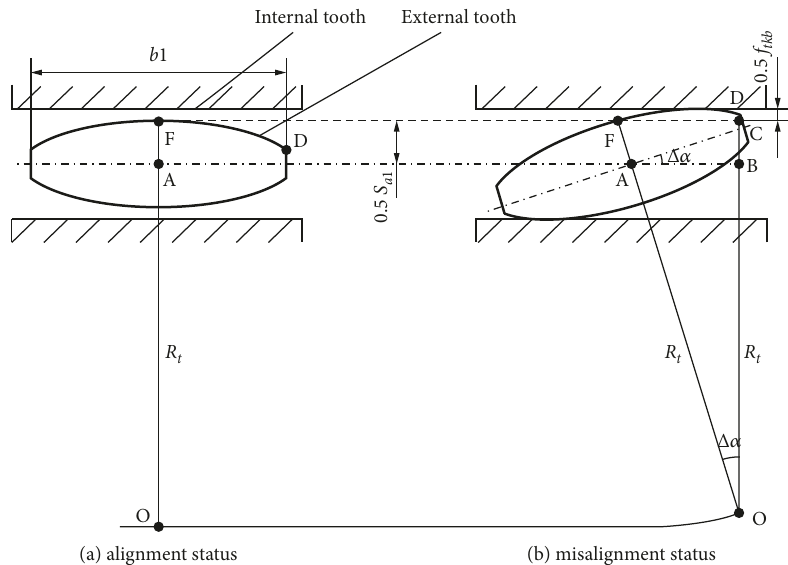
Figure 4: Schematic diagram of angular displacement of crown gear coupling.